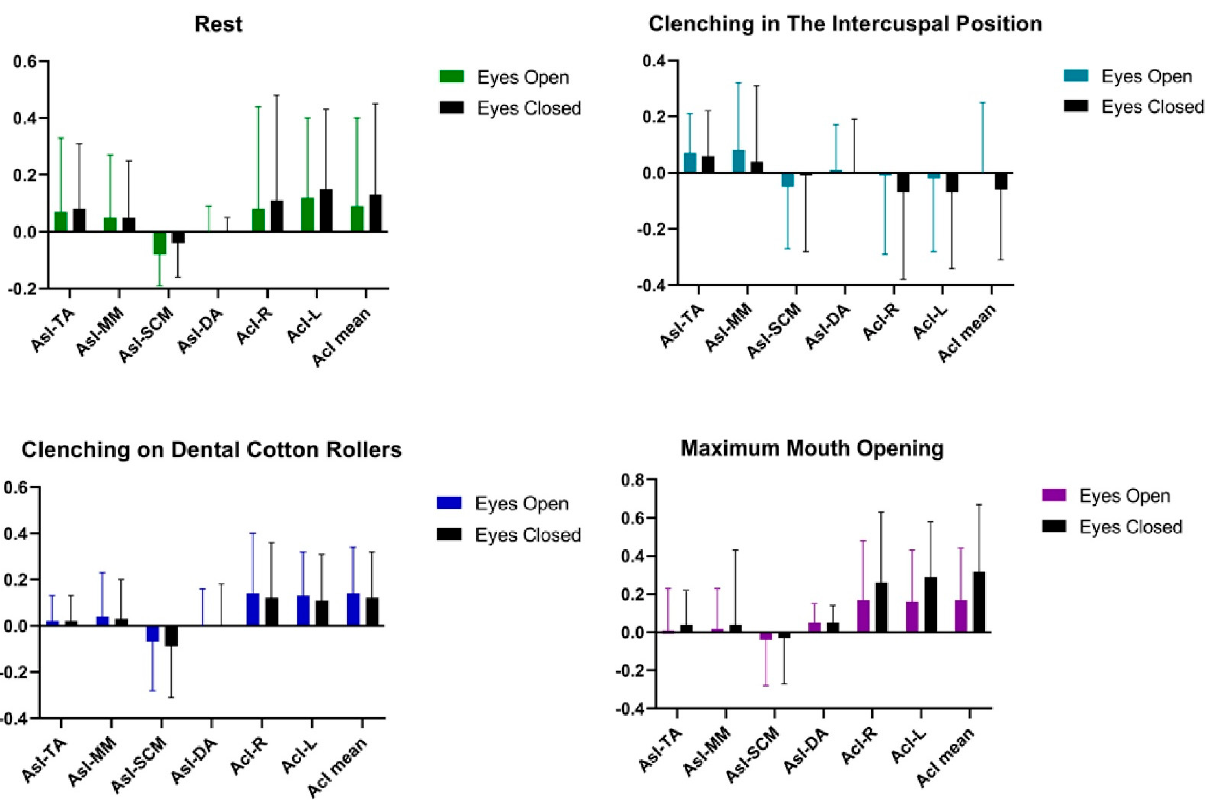
Figure 5. Graphical representation of bioelectrical patterns of selected muscles of the masticatory and cervical spine muscles in men. AcI—Activity index; AsI—Asymmetry Index; TA—the anterior part of the temporalis muscle; MM—the superficial part of the masseter muscle; SCM—the middle part of the sternocleidomastoid muscle; DA—the anterior belly of the digastric muscle.